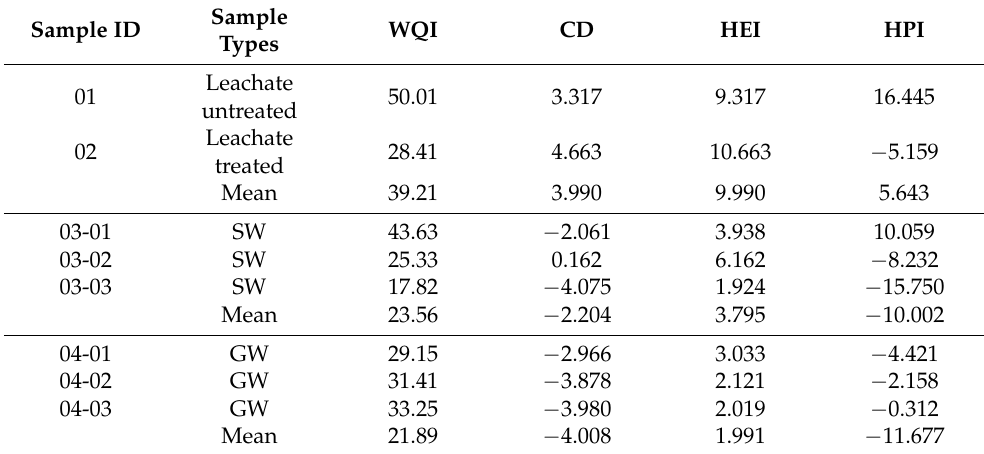
Table 6. Water quality index (WQI) and pollution indices including degree of contamination (CD), heavy metals evaluation index (HEI), and heavy metal pollution index (HPI) for leachate, surface water (SW), and groundwater